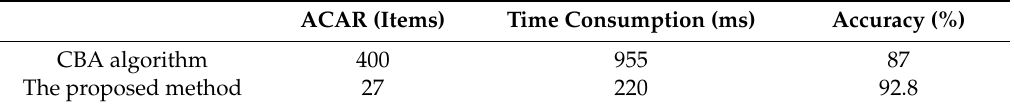
Table 2. Comparison of classification performance between the proposed method and CBA.